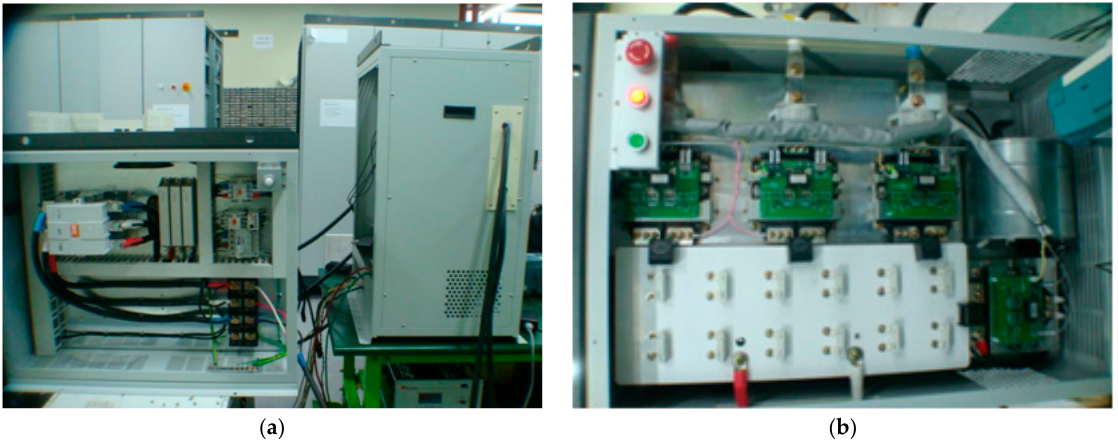
Figure 6. Prototype of a 200-kW inverter. ( a ) Exterior of inverter; ( b ) gate driver.